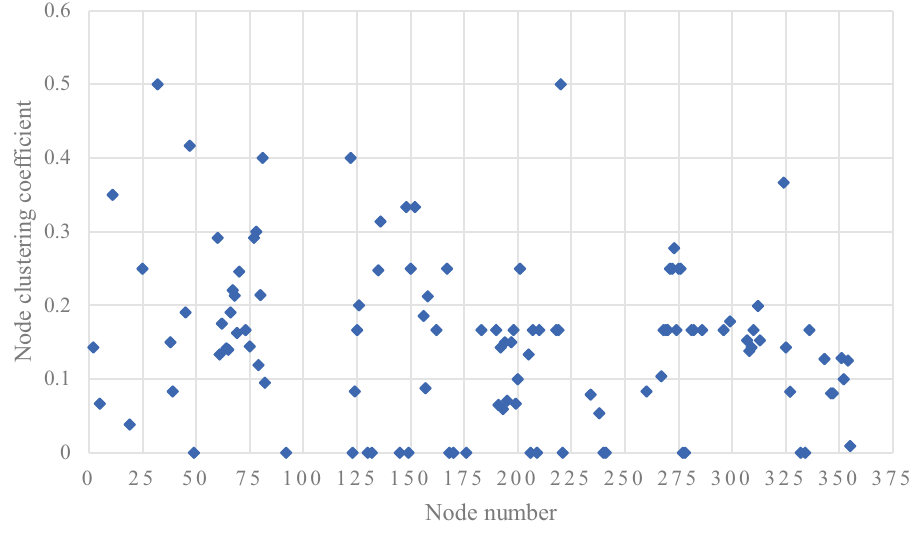
Figure 4. Clustering coefficient of nodes in the